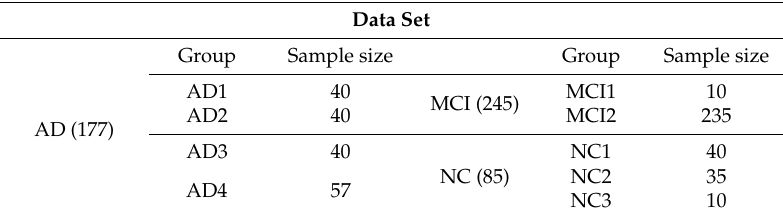
Table 4. Detailed information of data setting.